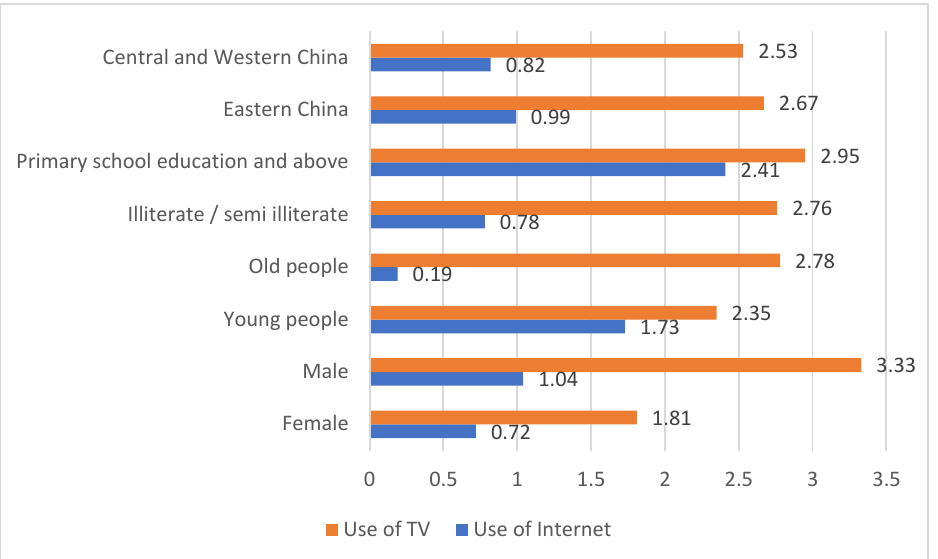
Figure 4. Comparison of the number of days that rural residents in different groups used the Internet and TV.